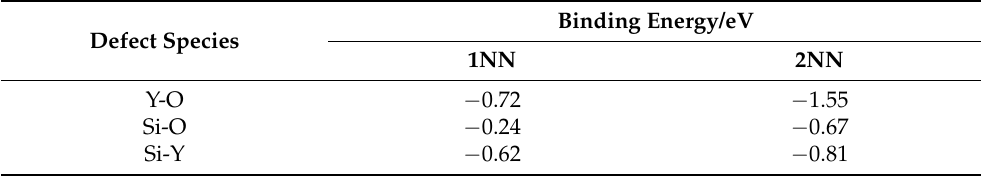
Table 5. The binding energies between solutes Y, O and Si (1NN and 2NN).